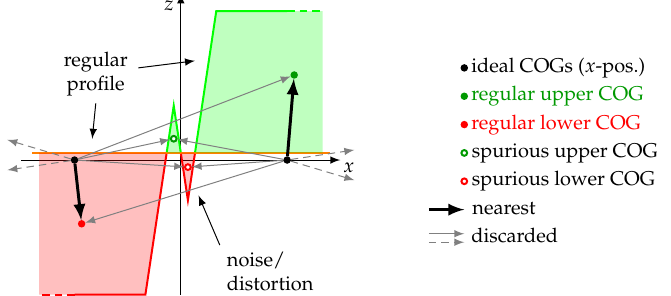
Figure 9. Spurious COGs, caused by additional crossings of the profile line and the threshold line, e.g., because of noise. To eliminate these, a sanity check and a selection of the detected COGs is executed. For this purpose, a synthetic grid of ideally spaced COGs (black dots) is generated and the nearest COG, obtained from measuring data, is determined (black arrows). All other COGs are discarded for this particular ideal COG (grey arrows). Only COGs related to the ideal grid are used for the subsequent